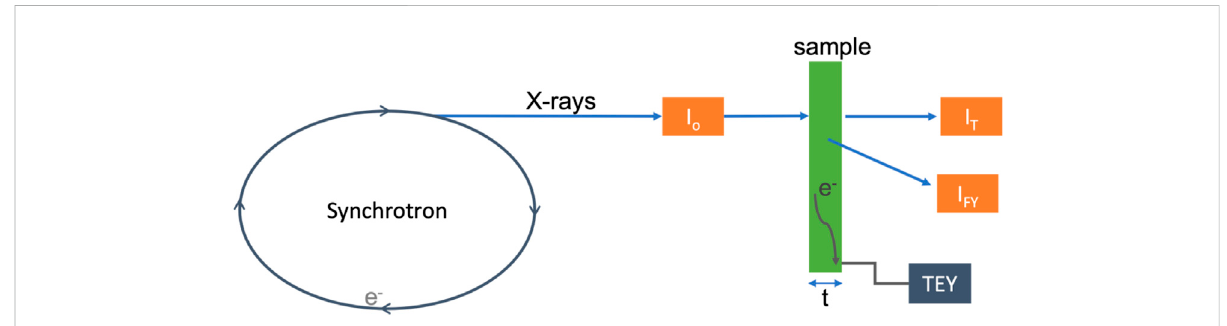
FIGURE 4 Simpli fi ed schematic of an XAS experiment, with the sample in green. The orange boxes represent detectors, where I o measures the incident photons, I T measures the transmitted photons, and I F measures the fl uoresced photons. The arrow with e − indicates electrons at the sample surface from excitation measured via electron yield experiments, indicated by the gray box labeled